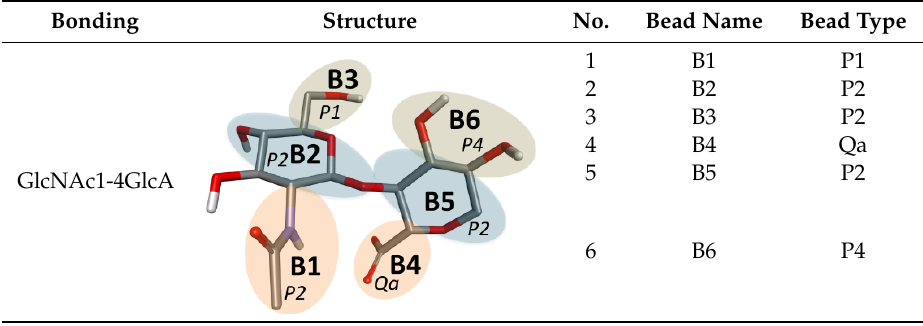
Table 2. Assignment of Martini CG bead types for HA1-4 disaccharide.